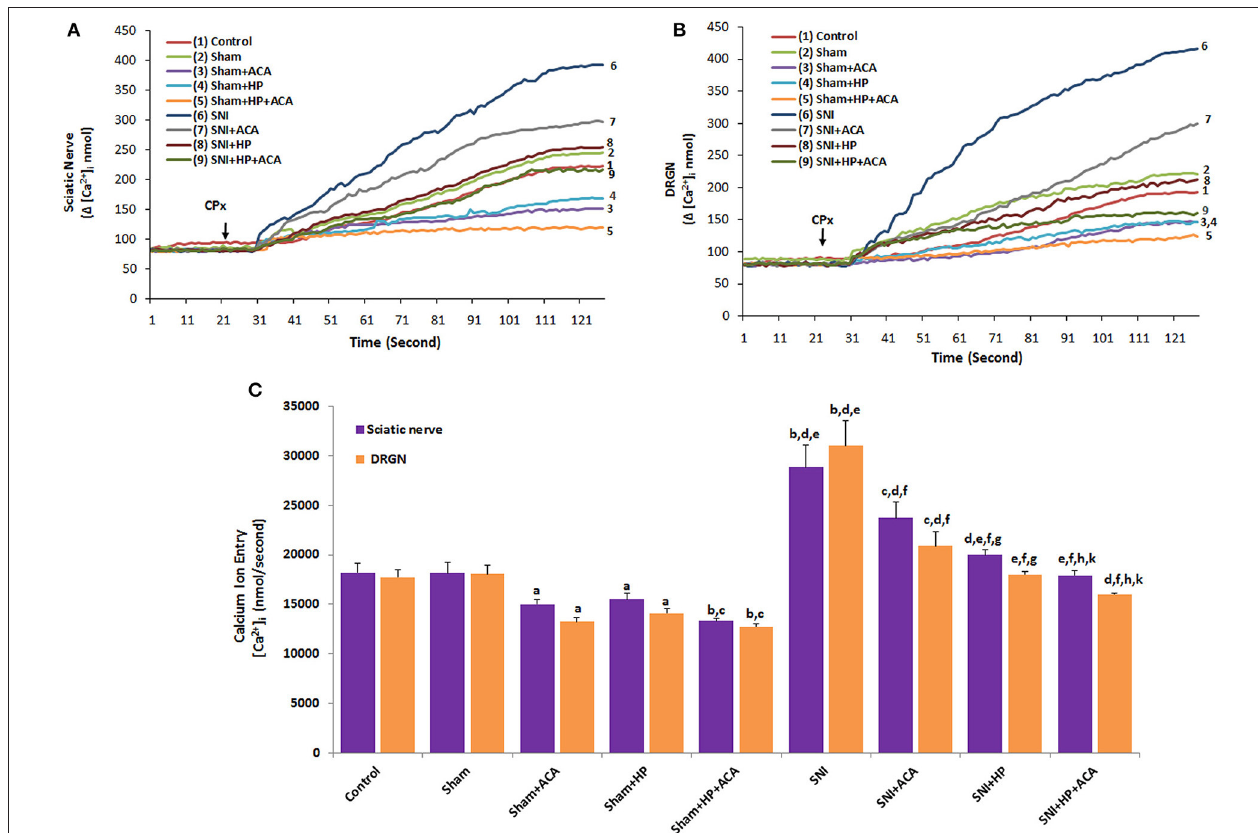
FIGURE 2 | Effect of Hypericum perforatum (HP) treatment on [Ca 2 + ] i concentration and TRPM2 in sciatic nerve (A) and dorsal root ganglion neurons (DRGNs) (B) of control, sham and SNI-induced rats. ( n = 8 and mean ± SD). The animals received oral HP for 4 weeks. Then, these dissected neurons of control, sham and SNI were further in vitro treated with CPx (0.1 mM) and ACA (0.025 mM) before loading Fura-2 for 125s. a p ≤ 0.05 and b p ≤ 0.001 vs. control and sham groups. c p ≤ 0.05 and d p ≤ 0.001 vs. sham + ACA and sham + HP groups. e p ≤ 0.001 vs. sham + HP + ACA group. f p ≤ 0.001 vs. SNI group. g p ≤ 0.05